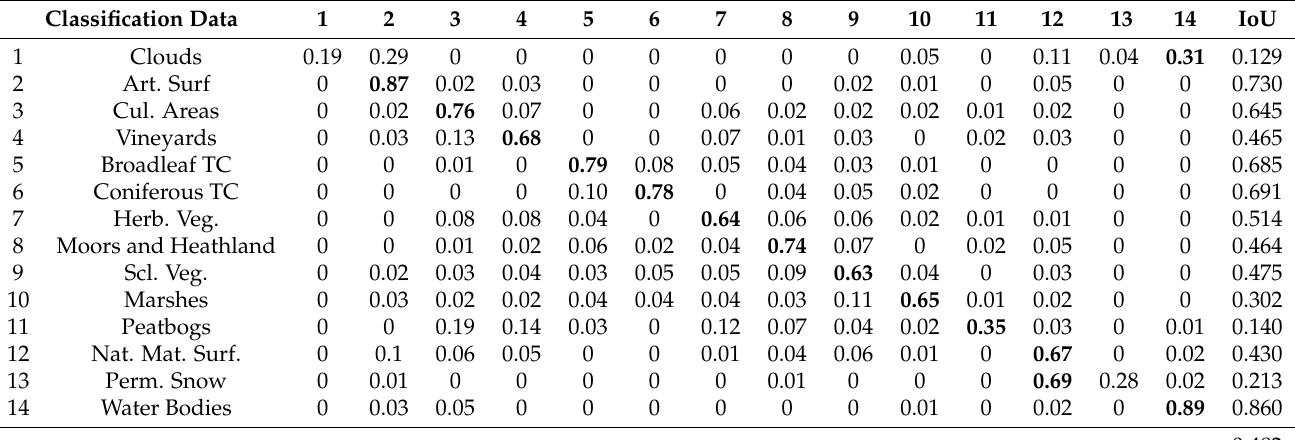
Table A1. Confusion matrix obtained for the original dataset and class IoU scores. Best values in bold. Classification